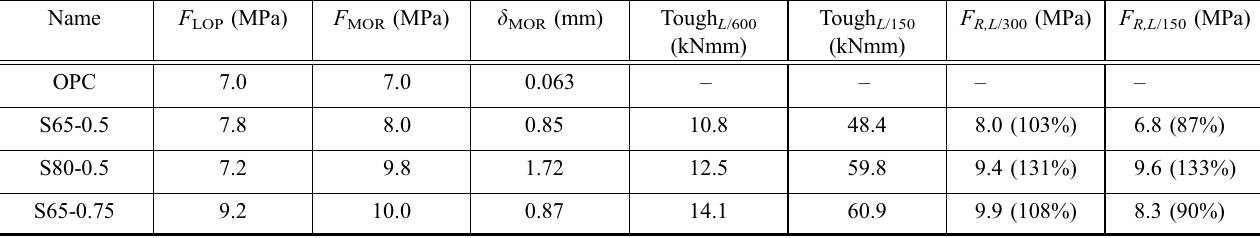
Table 6 Parameters obtained from four-point flexural tests (ASTM C1609).